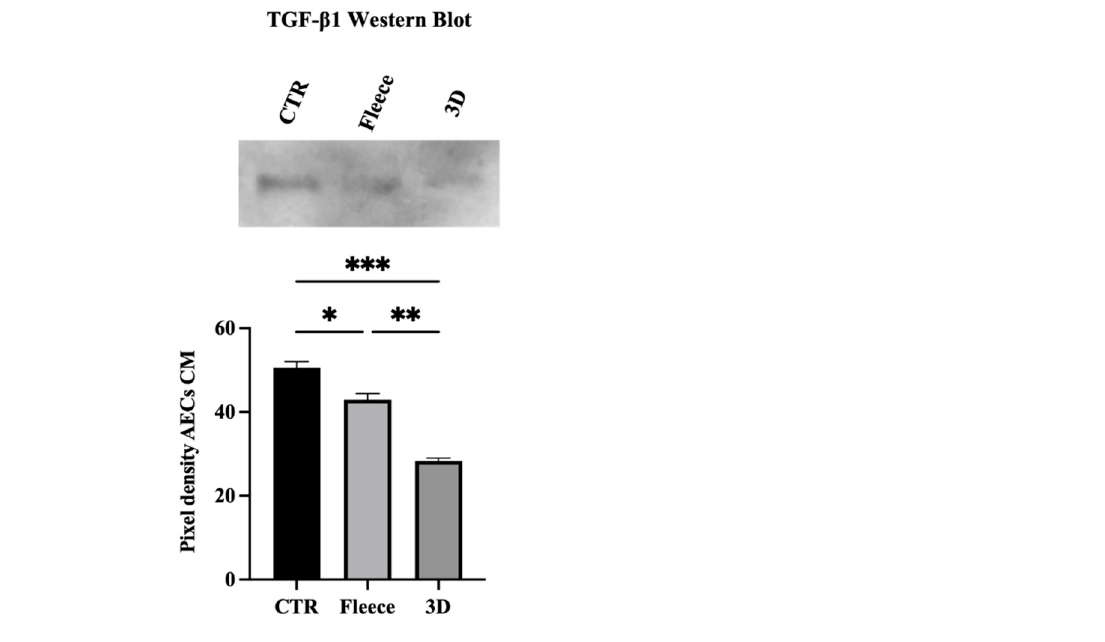
Figure 9. Western Blot confirms TGF- β 1 protein CM expression among the different groups as revealed thought the human inflammation antibody array analysis. *, **, and *** are statistically significant values between the different studied groups ( p < 0.05, p < 0.01, and p < 0.001, respectively).